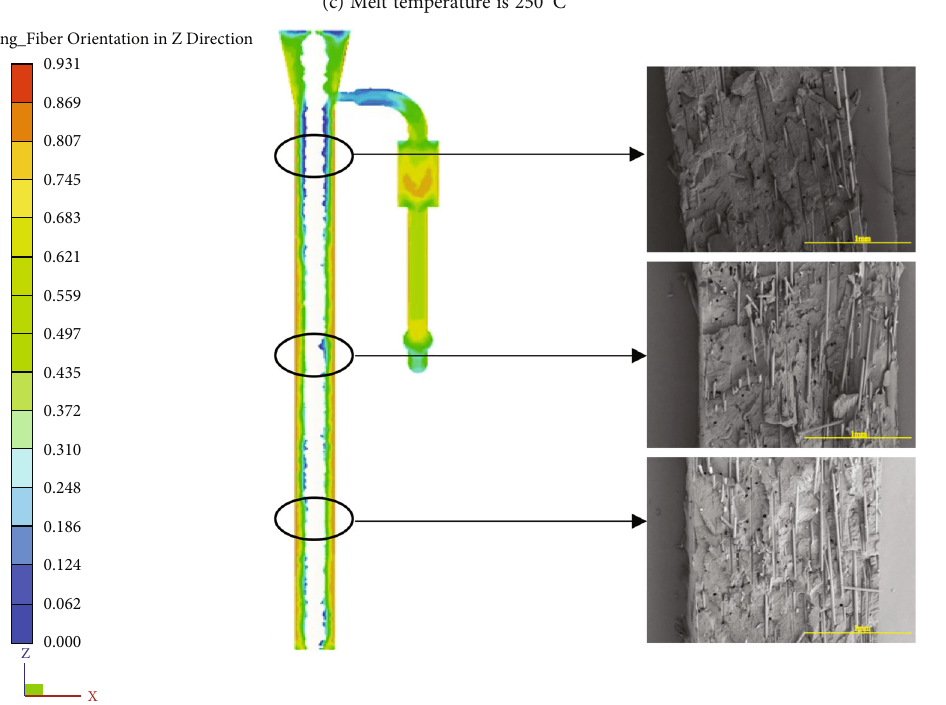
Figure 10: Fiber orientation distribution along the fl ow direction at di ff erent melt